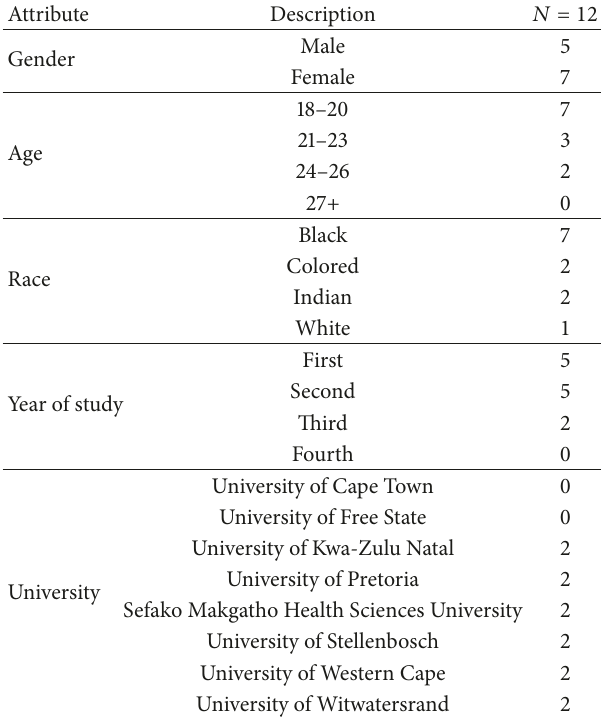
Table 2: Participant demographics of personal narrative